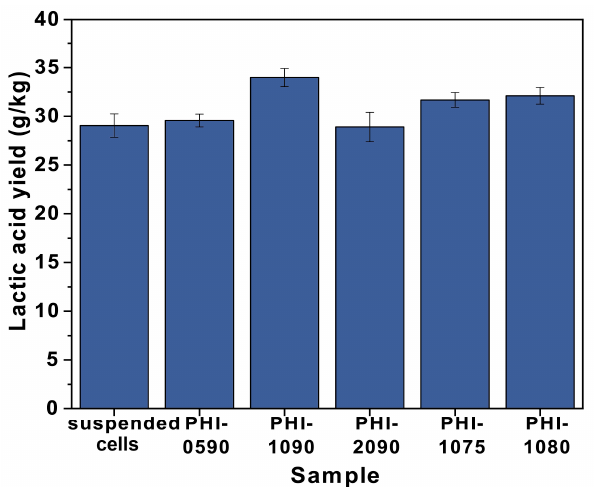
Figure 6. The L -lactic acid concentration for suspended and immobilized P. acidilactici on different PolyHIPE scaffolds at 42 °C.